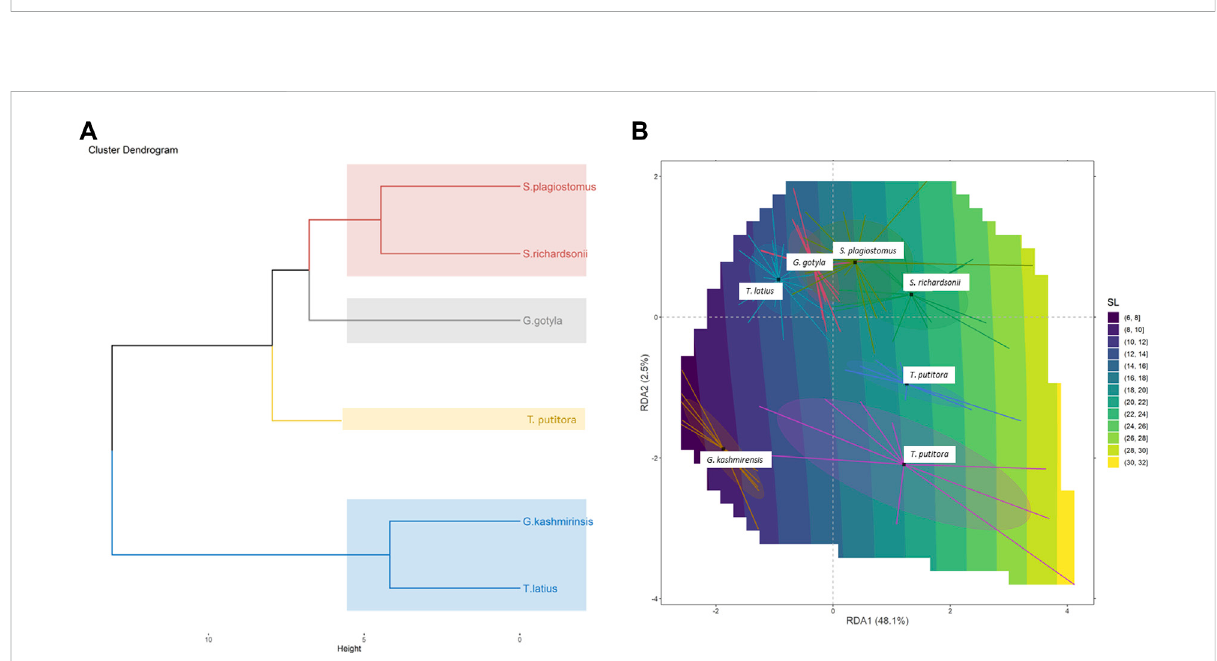
FIGURE 4 (A) Redundancy analysis (RDA) Biplot showing taxonomic division among six fi sh species collected from River Poonch. (B) Cluster dendrogram derived from morphometric